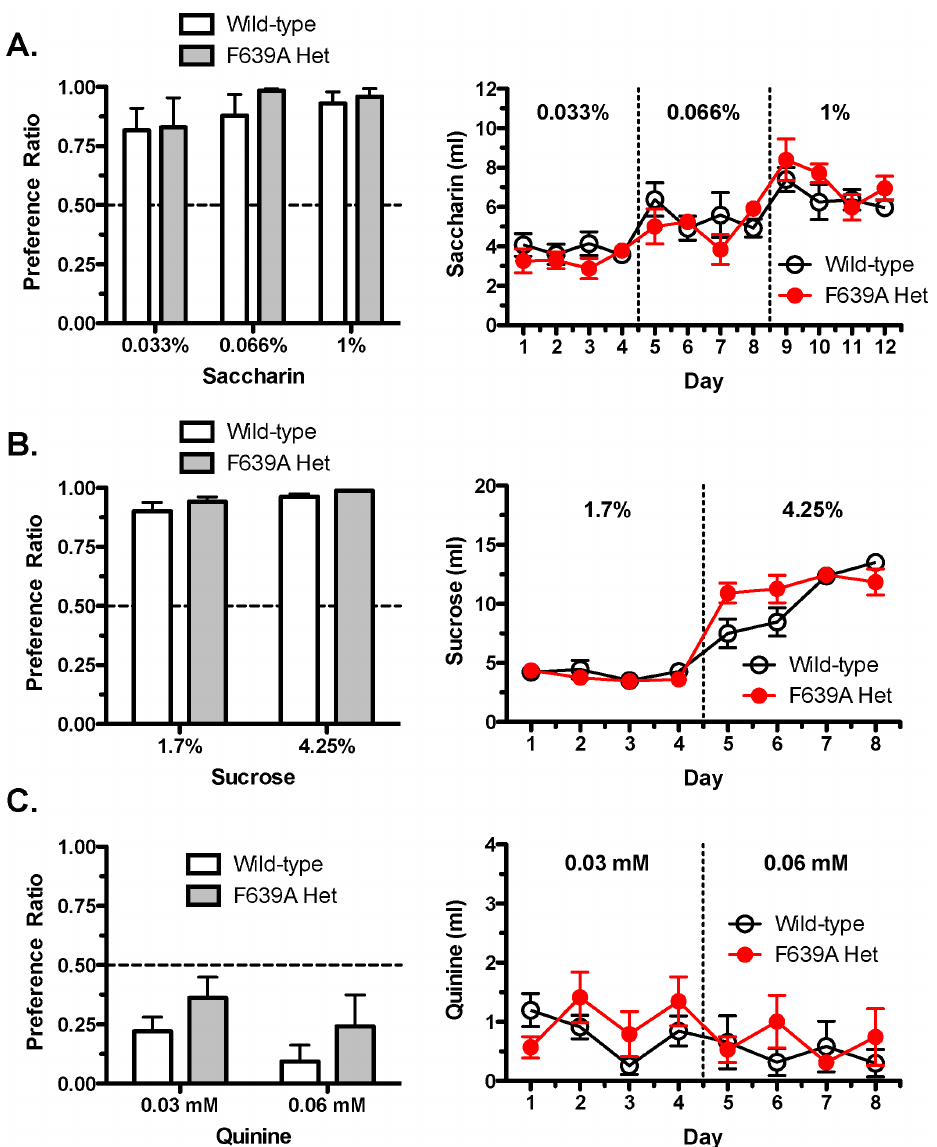
Figure 9. F639A Het and wild-type mice do not differ in taste reactivity. Consumption in wild-type and F639A Het mice was measured using a two-bottle choice test with 24 h continuous access to tastants (n=7 for each group). Left panels show preference ratio for volume of tastant solution consumed over water measured on the 4 th day of access for ( A ) saccharin, ( B ) sucrose, and ( C ) quinine. Right panels show corresponding volumes consumed across days for each tastant. Values are mean 6